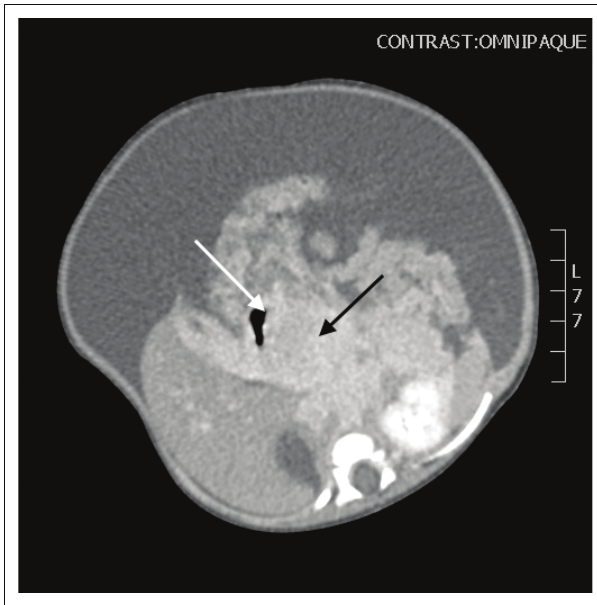
FIGURE 1: Coronal post-contrast computed tomography image demonstrating an ill-defined, enhancing mass in the head of the pancreas (black arrow), with a poor plane of separation from the D2 segment of the duodenum (white arrow) and peripancreatic extension to the porta hepatis (white star). Secondary findings of ascites (black star).